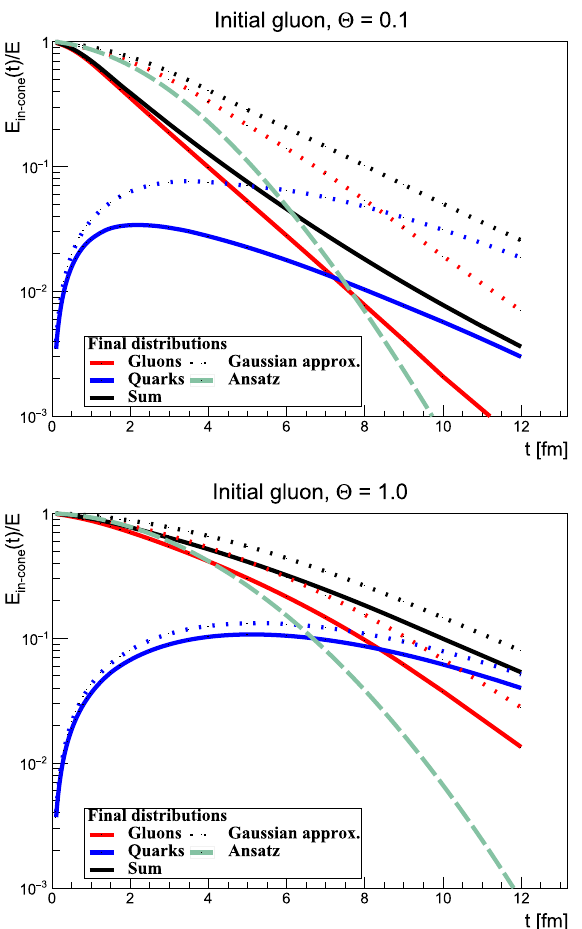
Fig. 11 Time evolution of the jet energy in a fixed cone with θ = 0 . 1 Gaussian approximation in Eq. (50) (dotted lines) and the analytical (upper panels) and θ = 1 (lower panels) for the initial gluon jet (left Ansatz in Eq. (47) (green dashed line); the red lines correspond to the panels) and the initial quark jet (right panels) in the case of the k T - final gluon jets and the blue lines to the final quark jets. The curves for + l 2 ) ] (solid lines), the dependent branching and w( l ) ∝ 1 / [ l 2 ( m 2 the analytical Ansatz are plotted only in the case of pure gluon D